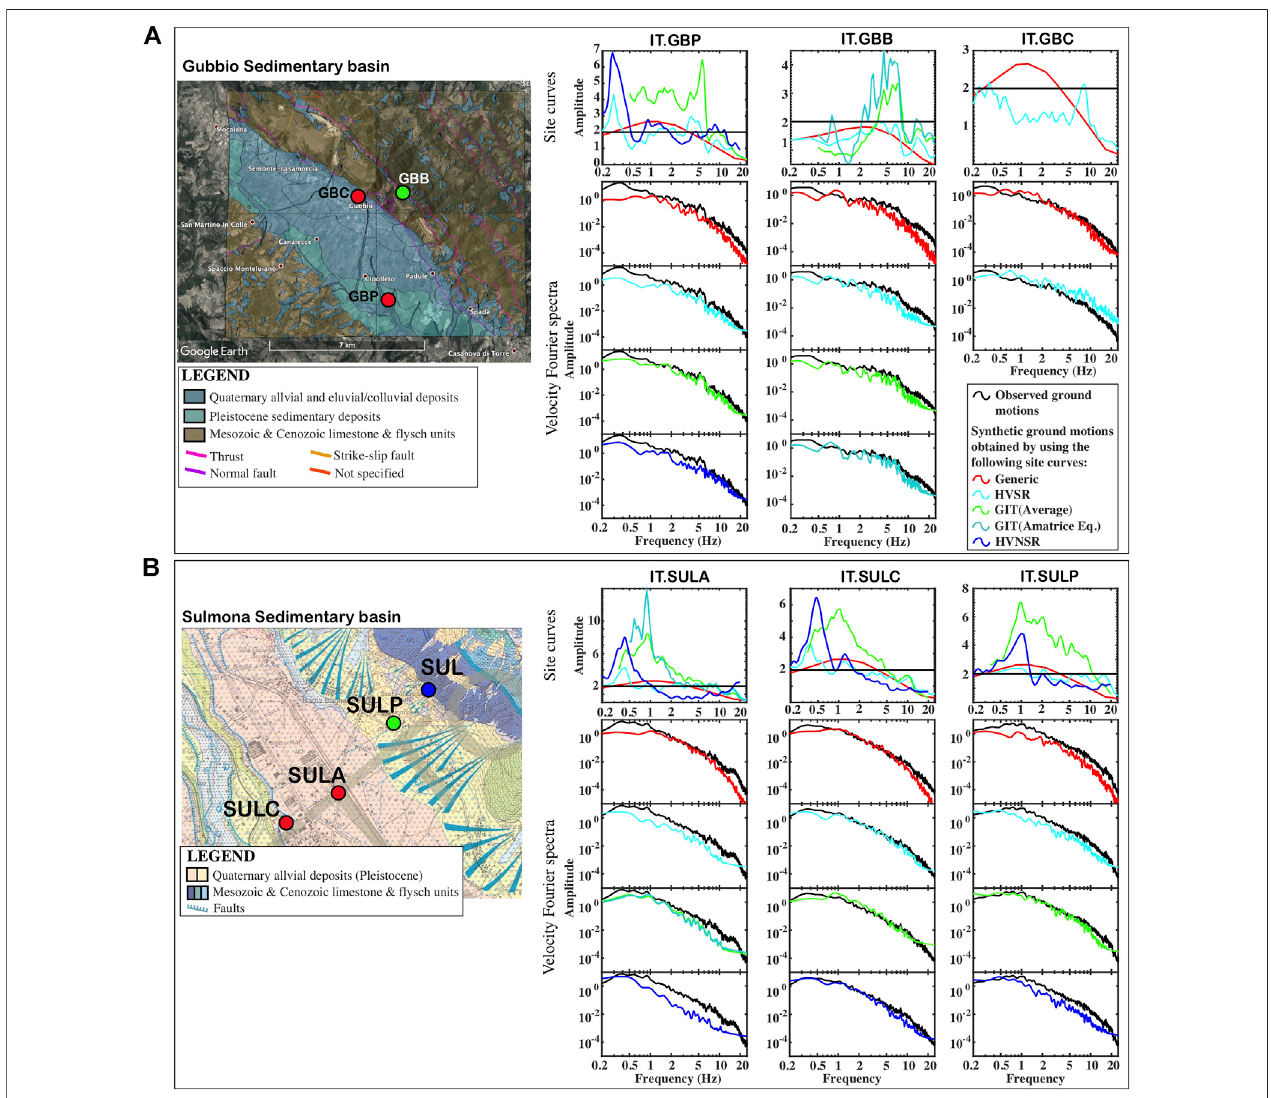
FIGURE 3 | Simulation results and records of Amatrice earthquake at Gubbio [panel (A) ] and Sulmona sedimentary basins [panel (B) ]. For each site, we add: a rough geological map of the area (provided in the ITACA database); the applied generic and empirical site curves at each station (consistently with Figure 2 ); Synthetic velocity Fourier spectra were obtained using the different site curves and recorded velocity Fourier spectra (geometric mean of the two horizontal components).